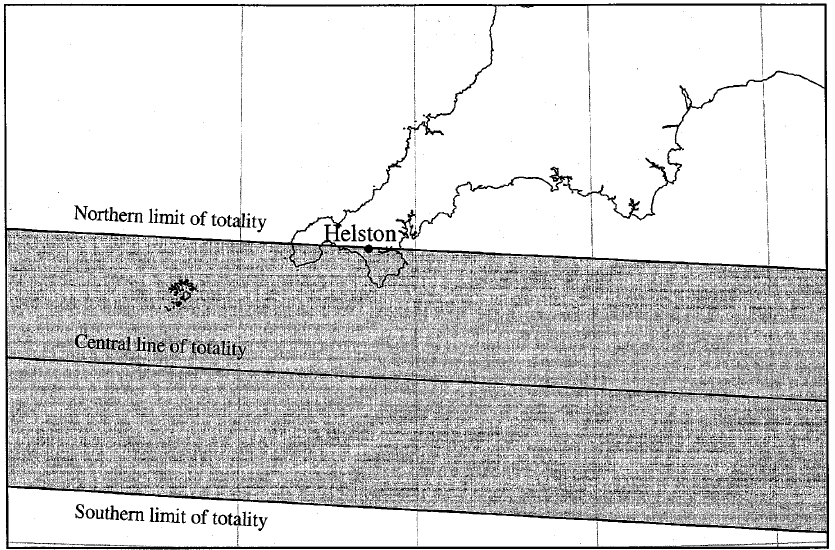
Fig. 1. The zone of totality at an altitude of 100 km across the southwest tip of the UK during the eclipse of August 11, 1999. The observation point at Helston lay on the extreme northern limit of this zone where totality lasted